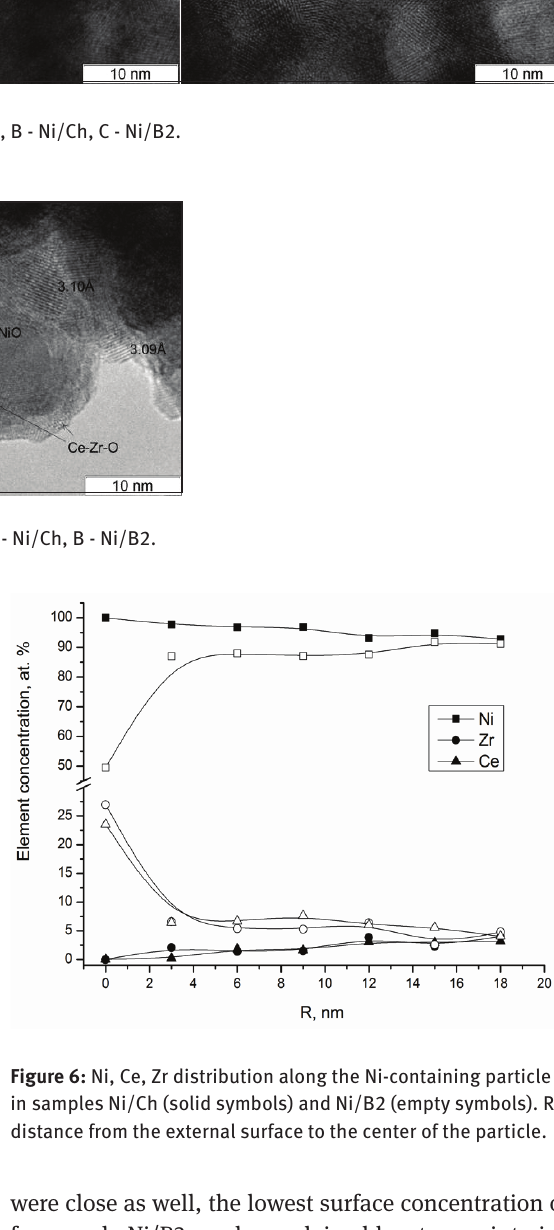
Figure 6: Ni, Ce, Zr distribution along the Ni-containing particle in samples Ni/Ch (solid symbols) and Ni/B2 (empty symbols). R - distance from the external surface to the center of the